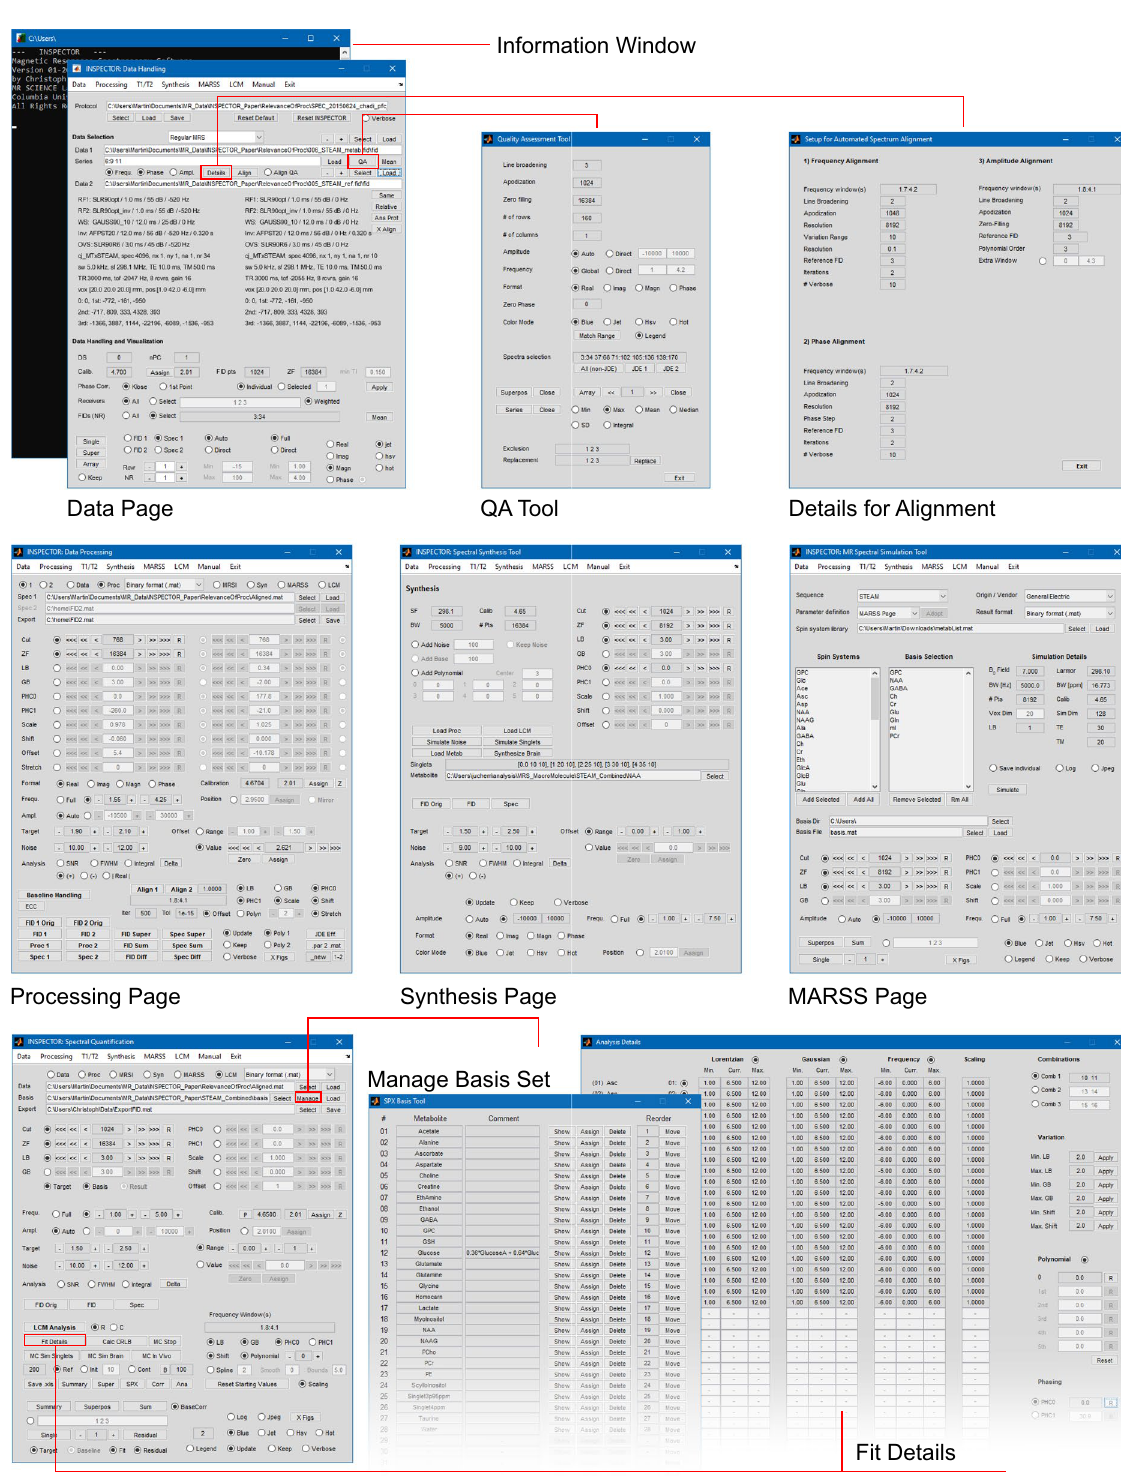
Figure 1. Graphical user interface in INSPECTOR for Microsoft Windows 10. The pages can be selected on the menu bar, and data can be transferred between